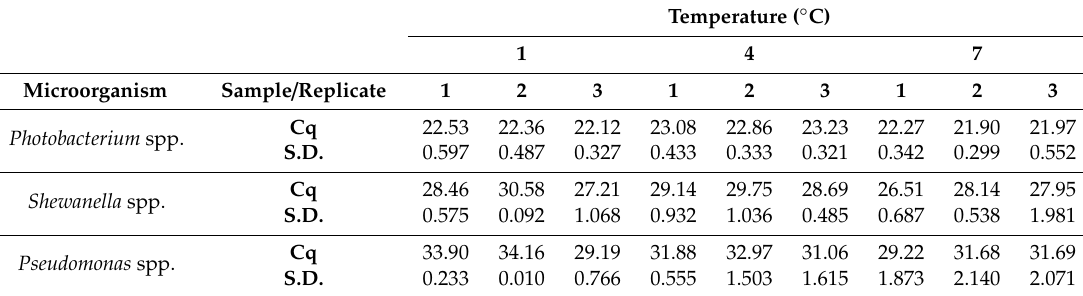
Table 4. Mean quantitation cycle (Cq) values (calculated from three technical replicates) for Photobacterium spp., Shewanella spp., and Pseudomonas spp. determined for each of the three independent samples (biological replicates) analyzed at the time of spoilage of hake fillets stored under MAP at the three studied temperatures. Data correspond to samples of batch A. The table also includes the standard deviation of the means.